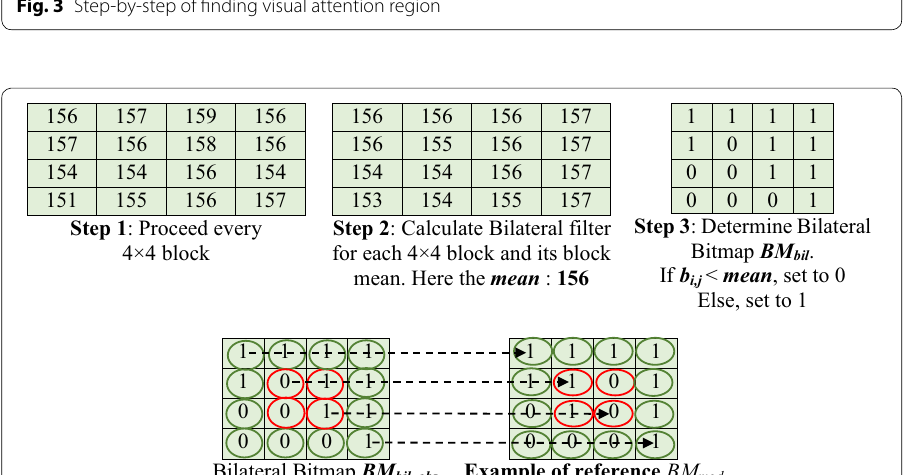
Fig. 4 An example of calculating distance between incoming block BM bil_obs and reference block model BM mod